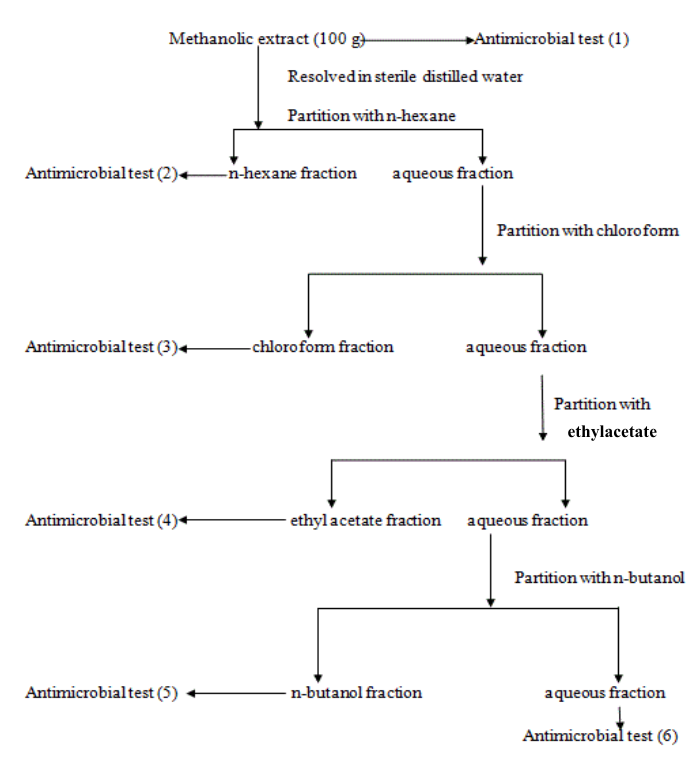
Figure 1. Extraction and Fractionation Scheme of the stem bark methanolic extract of P. biglobosa